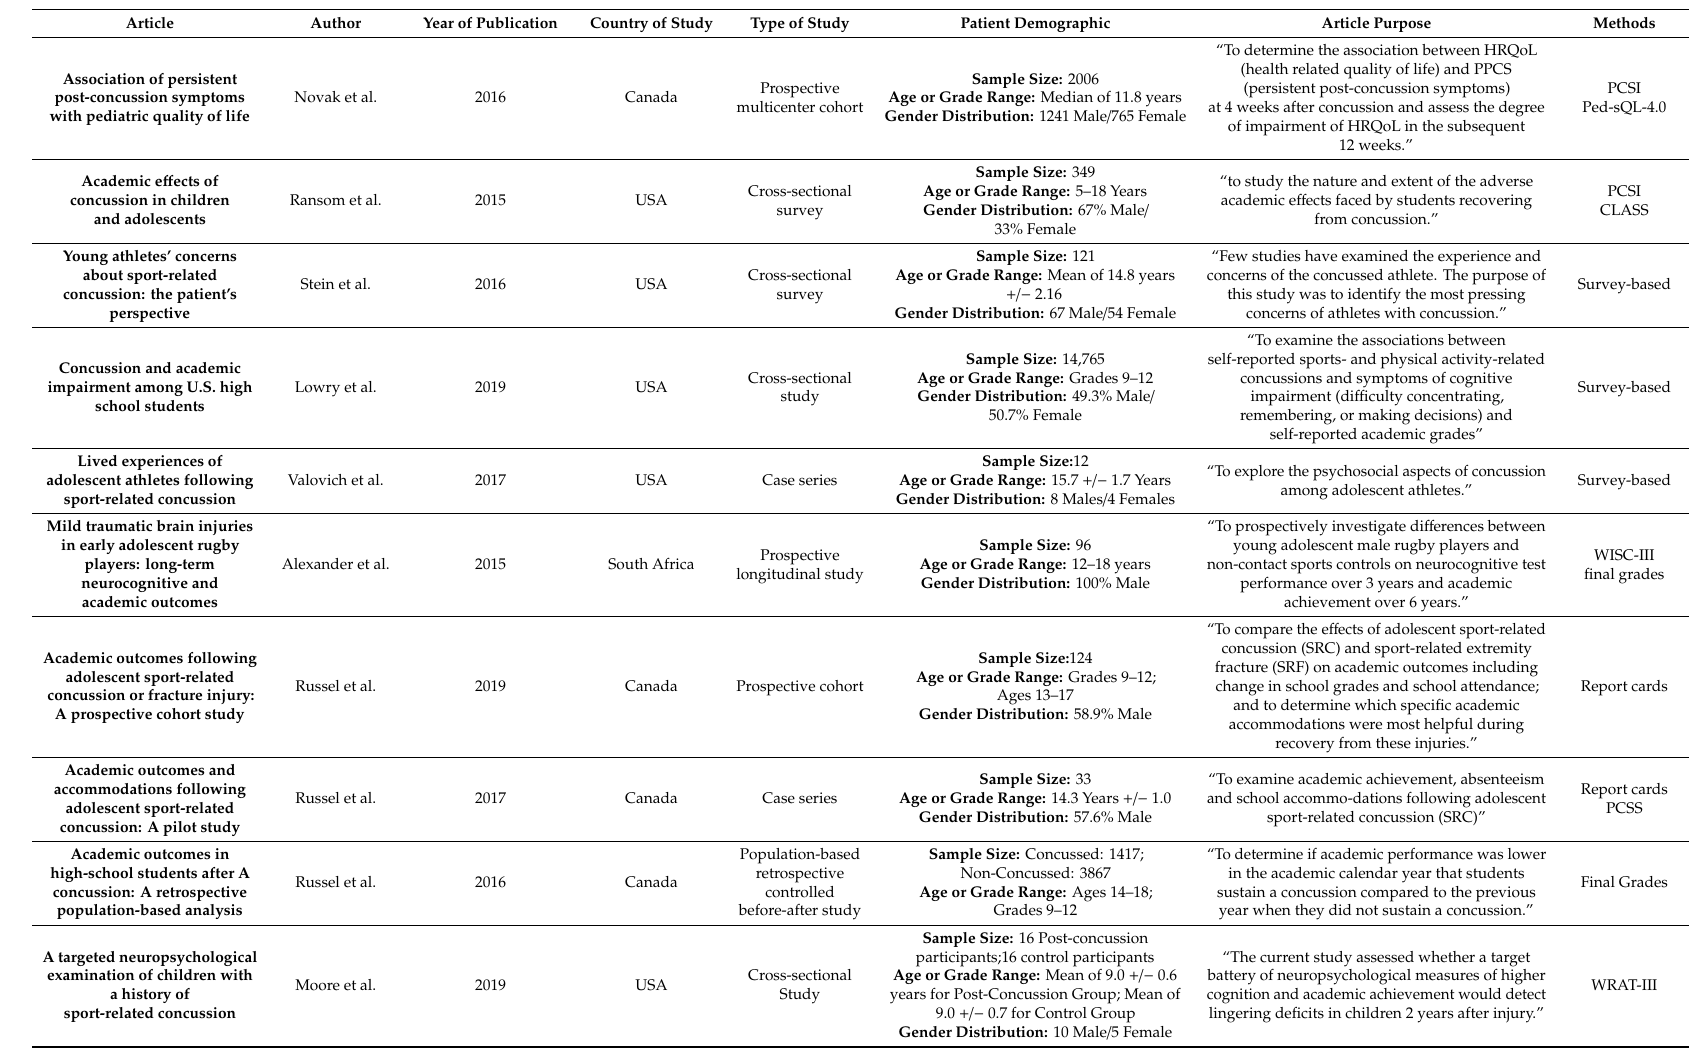
Table 1. Review of studies analyzing post-concussion academic performance and quality of life with methods utilized